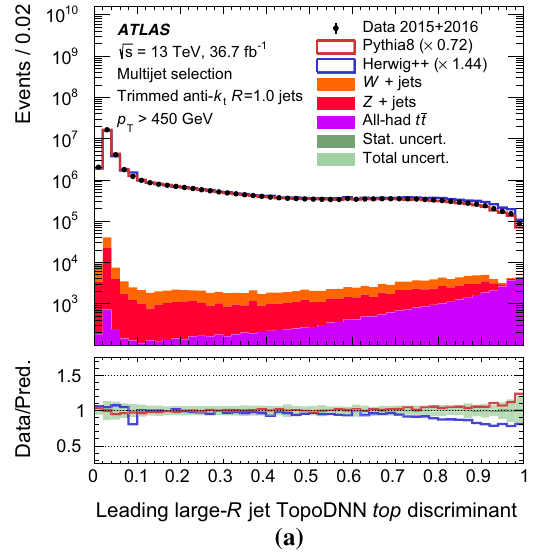
Fig. 28 A comparison of the observed data and MC predictions in the multijet ( a ) and γ + jet ( b ) event samples for the anti- k t R = 1.0 trimmed jet spectra of the TopoDNN top tagger discriminant. The data- driven normalisation correction, described in Sect. 6.2.1, is shown in